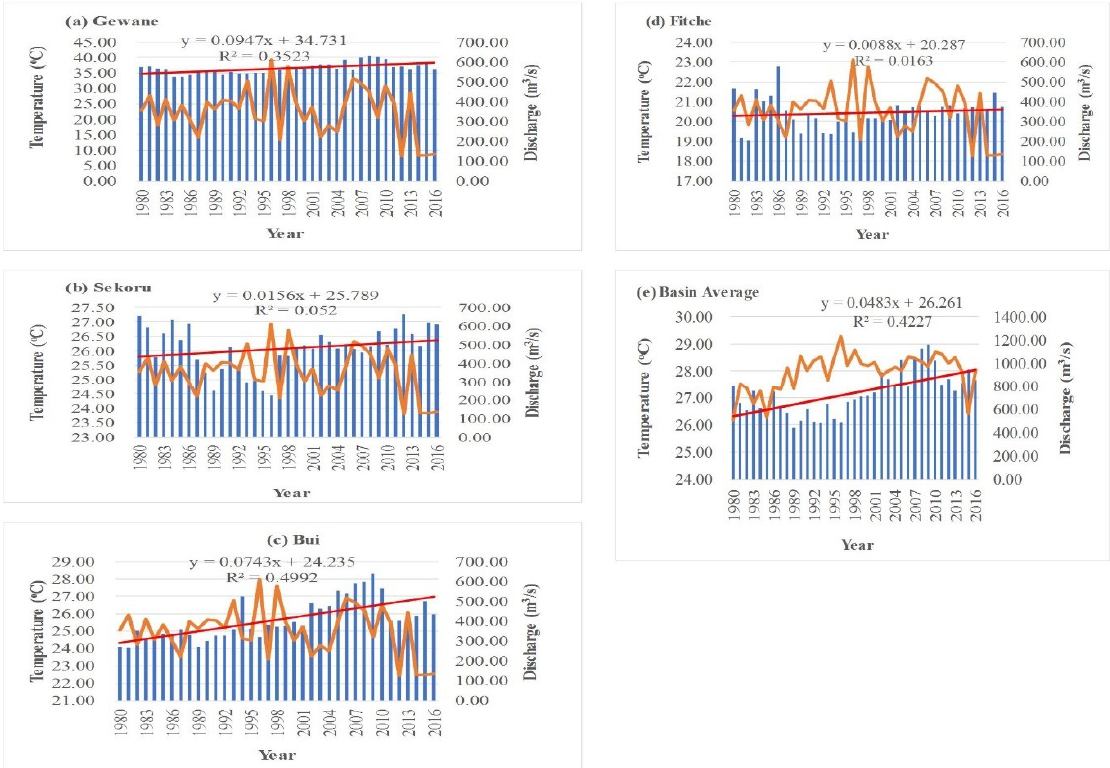
Figure 7. Long-term relation between temperature and discharge.